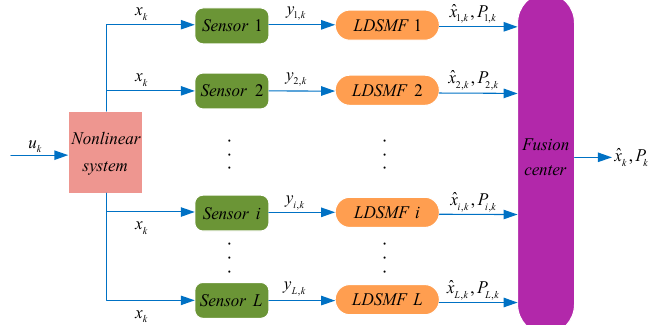
Figure 1. The architecture diagram of DSEI fusion positioning system.